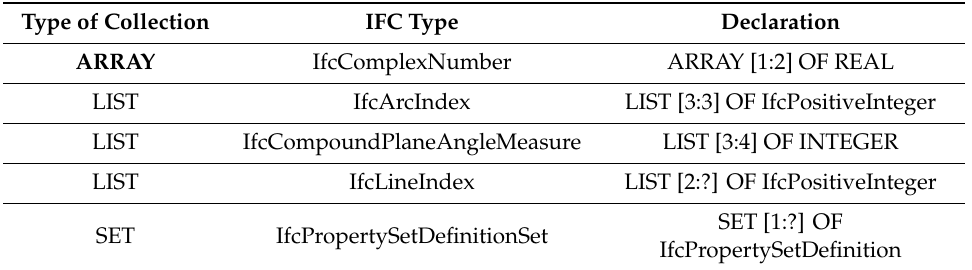
Table 5. IFC Aggregation datatypes.